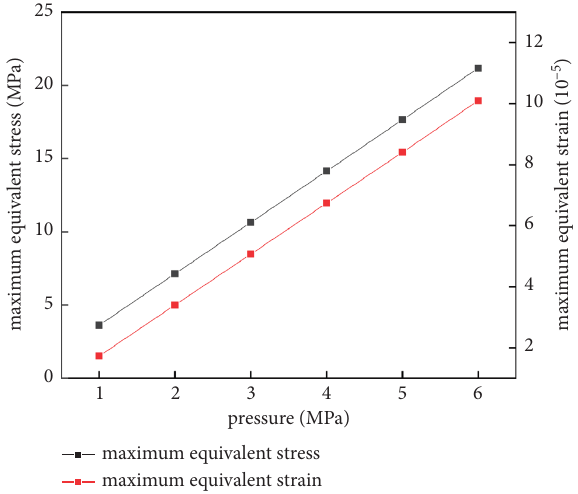
Figure 9: Variation curve of maximum equivalent stress and strain with drilling fluid